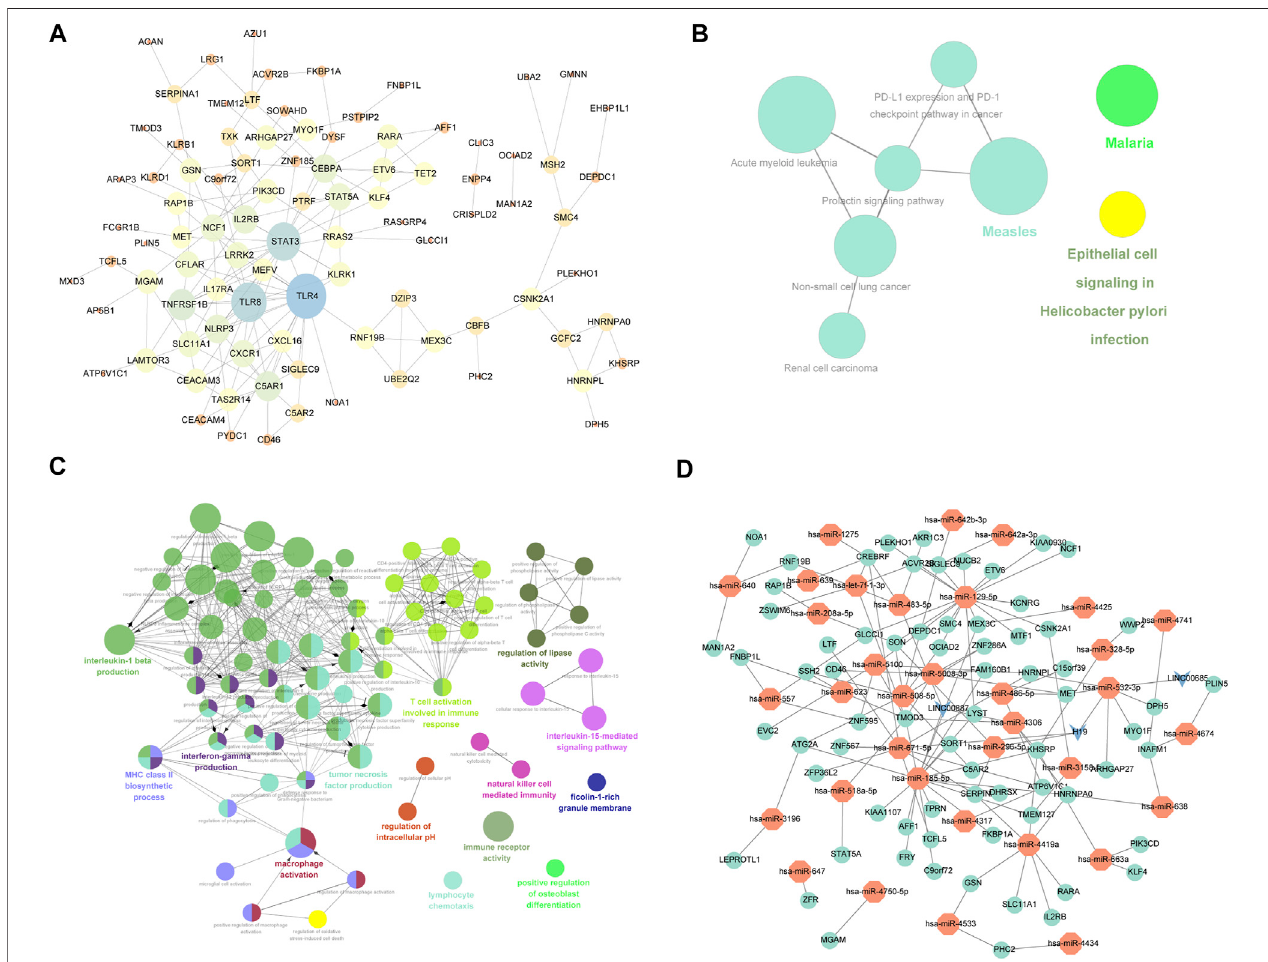
FIGURE 5 | mRNA-related PPI networks and ceRNA networks differentially expressed in IDD. (A) Protein interaction network of differentially expressed mRNA associated with disc degeneration. (B) clueGO-GO analysis of genes in PPIs that differentially express mRNAs associated with disc degeneration. (C) clueGO-KEGG analysisofgenesinPPIsthatdifferentially expressmRNAsassociatedwithdiscdegeneration. (D) ceRNAnetworkofhubgenes.Therednoderepresents thehubgene, the green node represents the miRNA that regulated the hub gene, and the blue node represents lncRNA. ( Figure 6B ). The changes in the CCs of hub genes were signi fi cantly enriched in cytoplasmic vesicles, lipid particles, and the plasma membrane ( Figure 6C ). The changes in the MFs